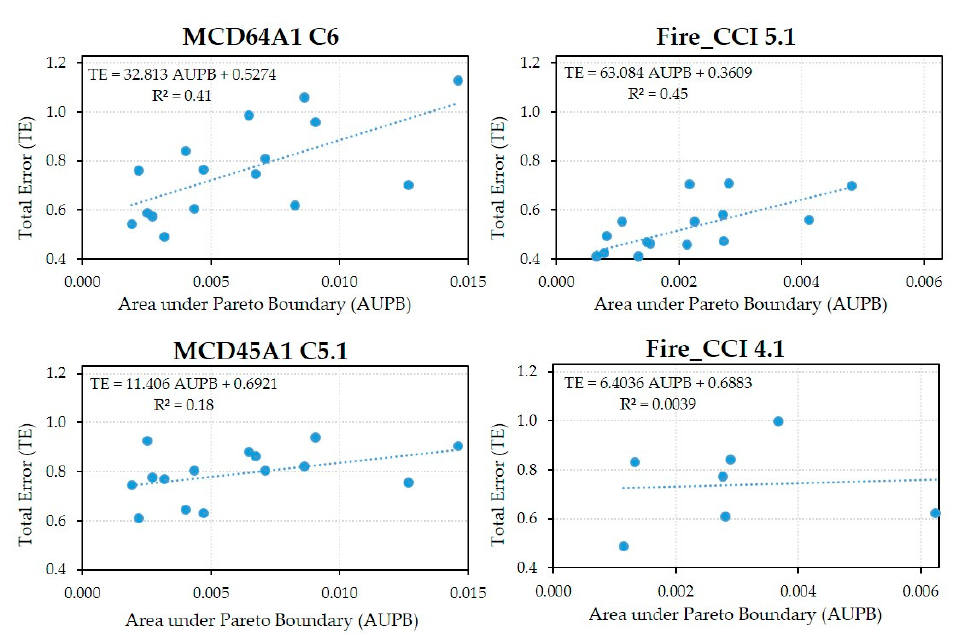
Figure 12. Scatterplots of the total annual TE errors (weighted sum of the annual commission and omission errors) versus the area enclosed by the annual Pareto boundary. Data for the years 2000 and 2001 were not included, as there were incomplete data from the MODIS sensor.